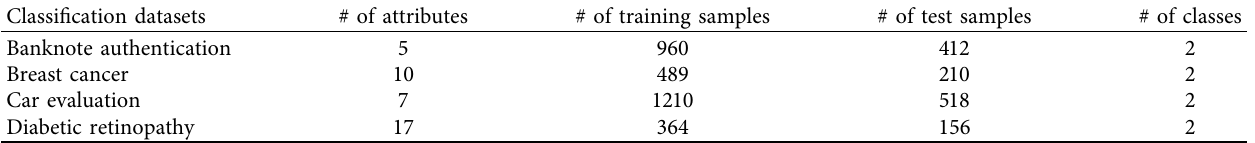
Table 1: Details of the classification datasets.